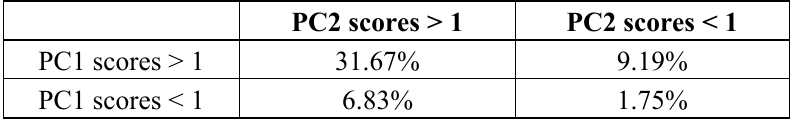
Table 6. Percentages of hyperlinks between blog performance